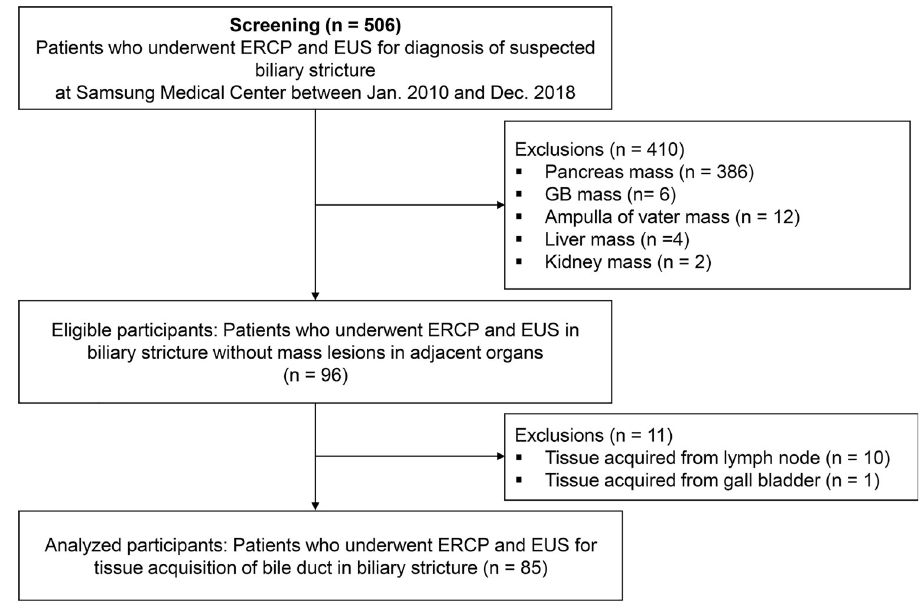
Fig 1. Flowchart of the